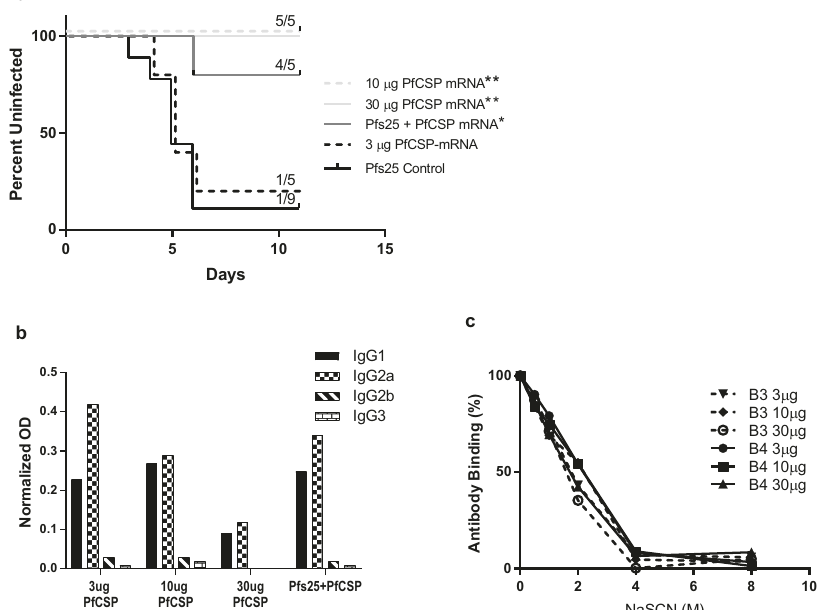
Fig. 5 PfCSP mRNA-LNP induced responses in mice and protection against sporozoite challenge after four immunizations. Mice ( N = 5 per group) immunized with 3 μ g, 10 μ g, 30 μ g PfCSP mRNA-LNPs, or co-immunized with 10 μ g of both Pfs25 and PfCSP mRNA-LNPs (as per Fig. 1a) were challenged with PbPfCSP-GFPLuc sporozoites and progression of infection was monitored by microscope examination of giemsa-stained blood smears for 11 days following challenge. Pfs25 immunized mice were used as negative controls. a Kaplan – Meier survival curves represent the percent of mice without detectable parasitemia following sporozoite challenge. Mice were considered completely protected if no parasitemia was detected by day 11. Statistical analysis was performed using log rank (Mantel-Cox) test (* p < 0.05; ** p < 0.01). Antibodies from sera, collected one-week prior to the second challenge, bleed B4 in Fig. 1a, were characterized for antibody isotype ( b ) by ELISA using IgG1, IgG2a, IgG2b and IgG3 speci fi c secondary antibodies. The optical densities (OD) of each isotype were normalized to the OD of total anti- mouse IgG. c Avidity was characterized by antibody-antigen dissociation curves resulting from treatment with different concentrations of NaSCN from sera collected from the Bleeds, B3 and B4, in Fig. 1a. The avidity index was calculated as the concentration (M) of NaSCN that resulted in 50% dissociation of bound